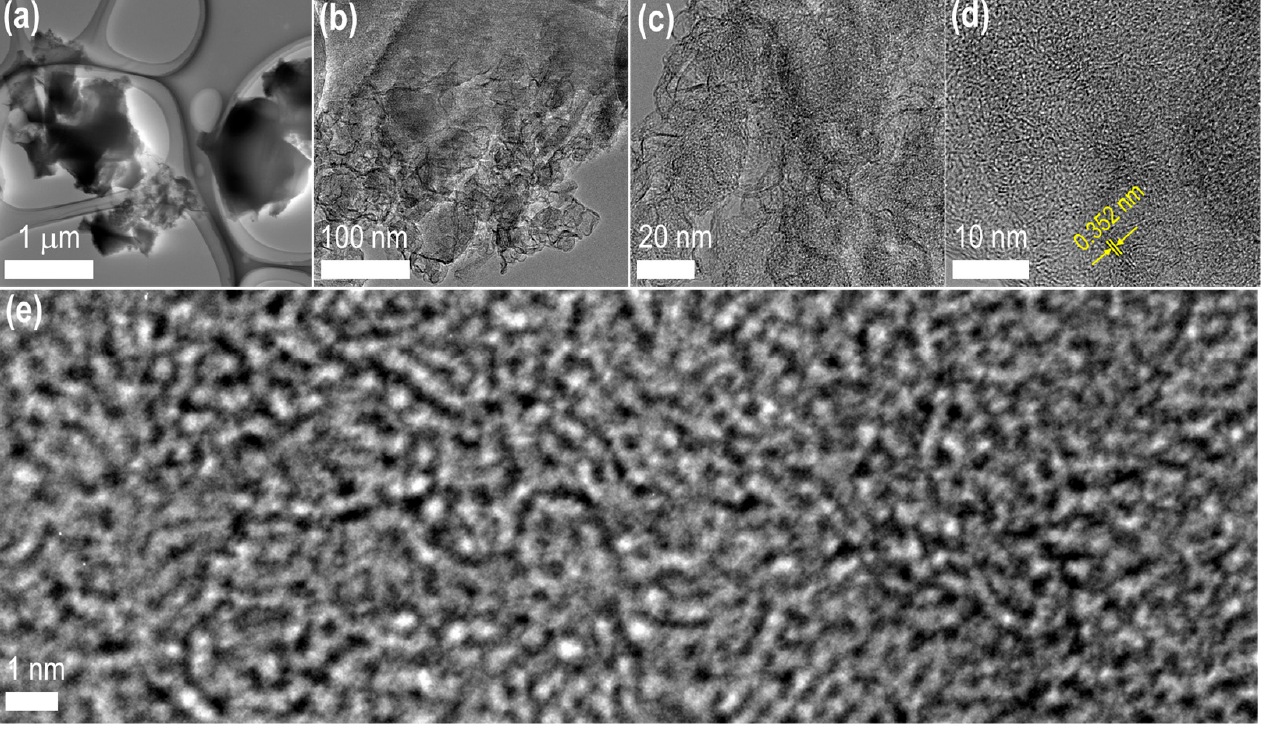
Figure 5. TEM observation of the optimal Amala-seed carbon sample, AmC_K900: ( a – c ) TEM images at different amplification; ( d ) high-resolution TEM image; ( e ) magnified HR-TEM image, showing microporous structure.